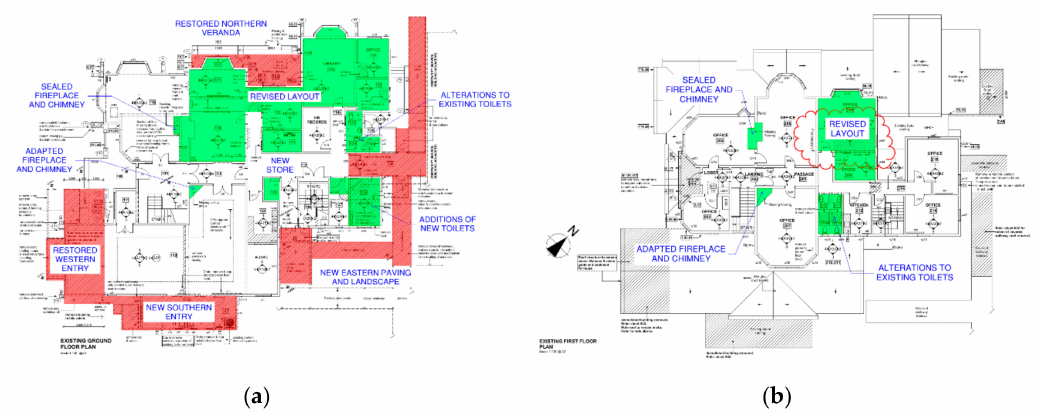
Figure 3. Proposed alterations for the conservation of McDougall House: ( a ) Ground floor; ( b ) First